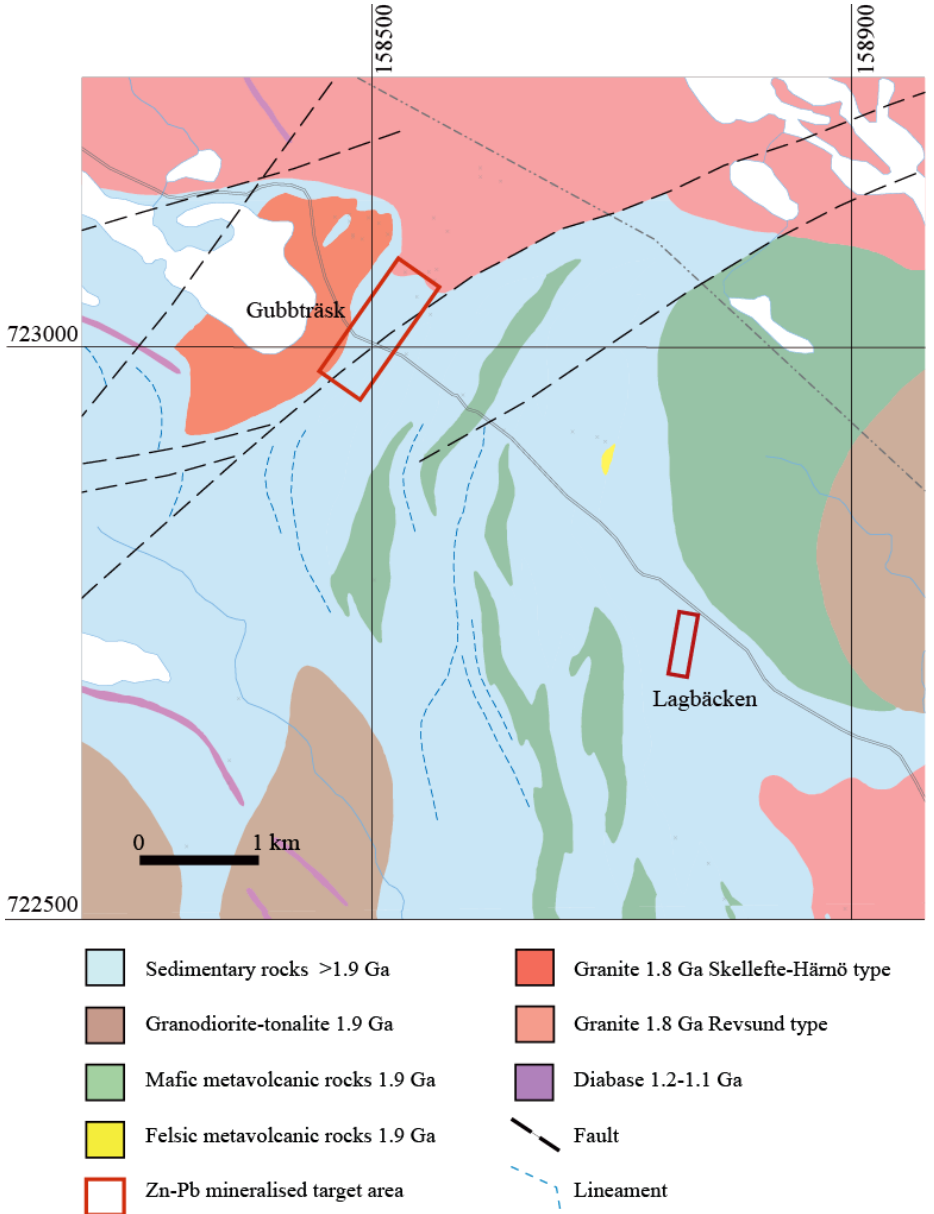
Figure 4. Geological map of the area enclosing the Zn-Pb occurrences at Gubbträsk and